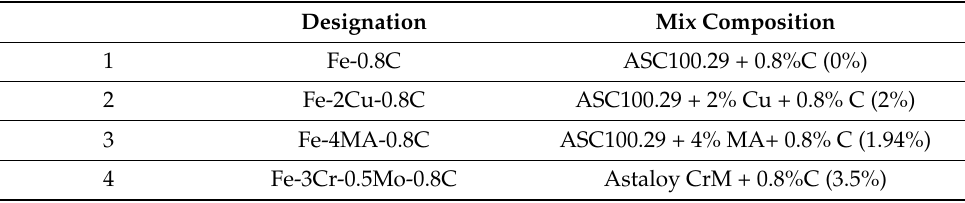
Table 4. Material composition of mixes in wt.% (in brackets: alloy element